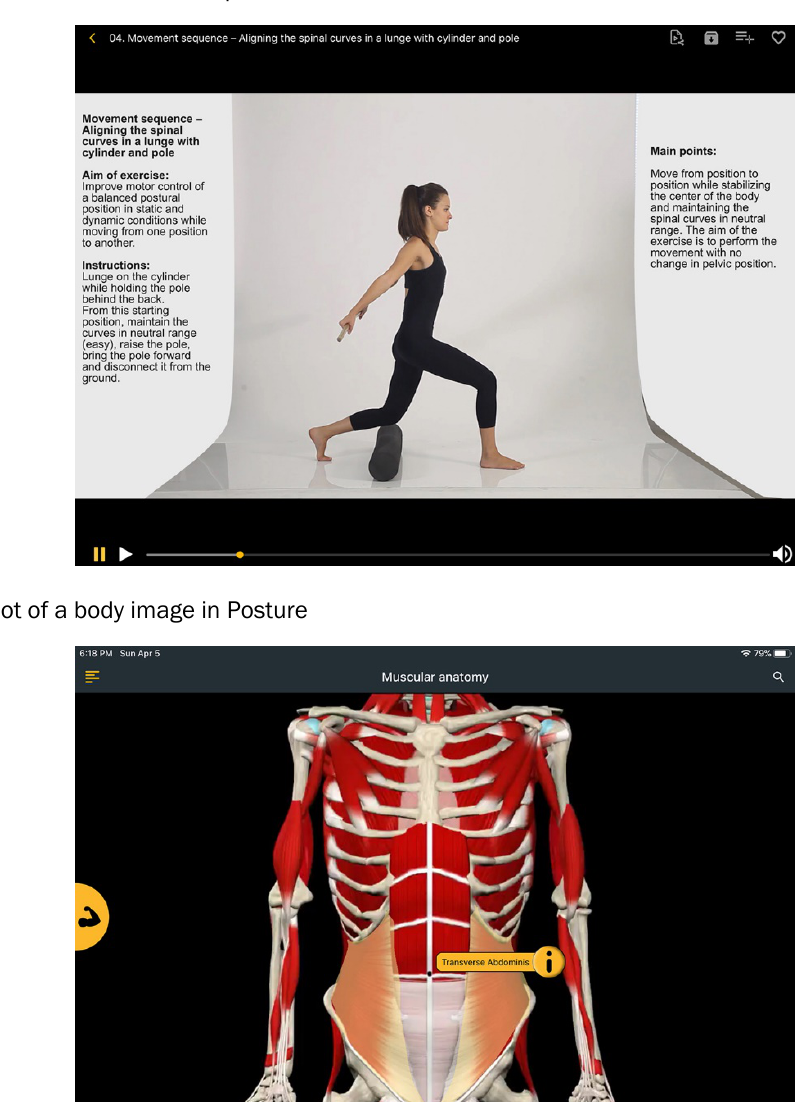
Figure 1 Screenshot of a movement sequence in Posture